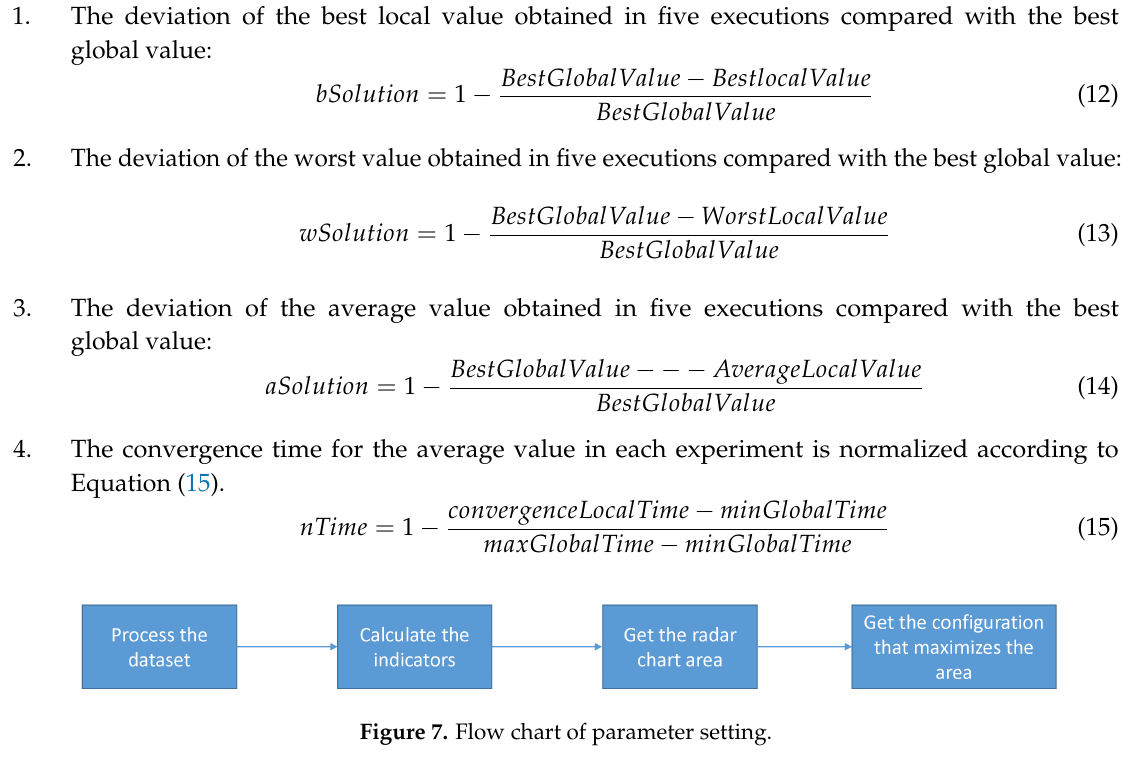
Figure 7. Flow chart of parameter